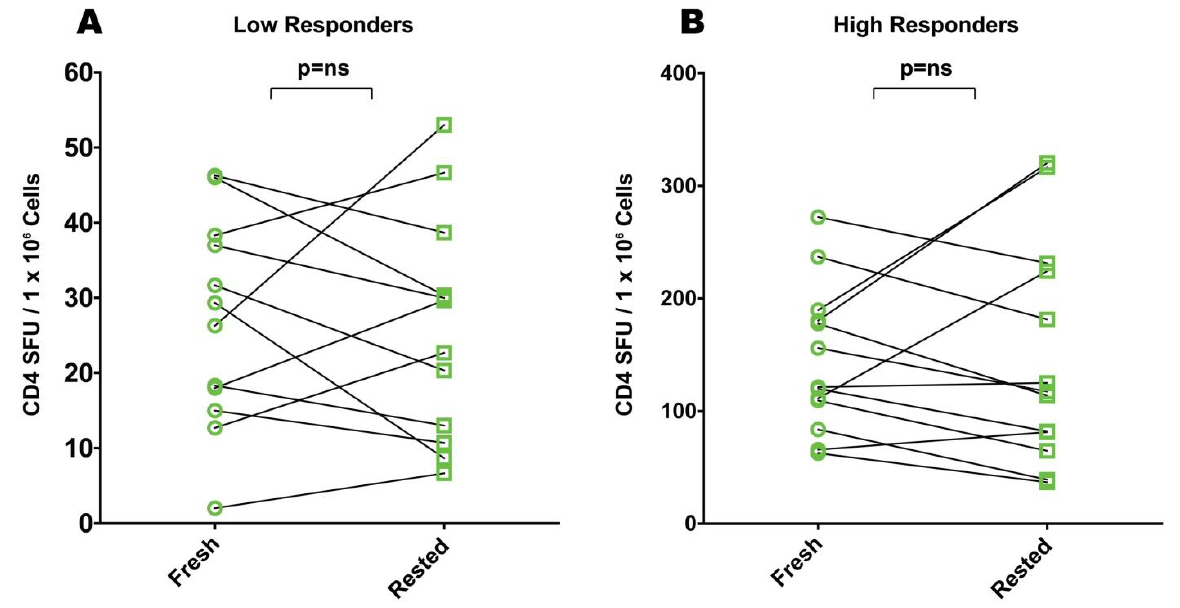
Figure 3. Comparison of mumps antigen elicited IFN- (cid:534)(cid:3) (cid:76)(cid:81)(cid:3) (cid:73)(cid:85)(cid:72)(cid:86)(cid:75)(cid:79)(cid:92)(cid:3) (cid:87)(cid:75)(cid:68)(cid:90)(cid:72)(cid:71)(cid:3) (cid:68)(cid:81)(cid:71)(cid:3) (cid:85)(cid:72)(cid:86)(cid:87)(cid:72)(cid:71)(cid:3) cryopreserved PBMC for low ( A ) and high responder subjects ( B ). Each data point represents the mean of triplicate antigen-stimulated wells. Standard deviations are not shown being between 5 and 20% of the mean. For each sample, fresh or rested, the medium background was less than 10 spots per well. Non-parametric Wilcoxon signed-rank test was used to compare matched fresh vs . rested responses with a p -value (cid:148) 0.05 being considered